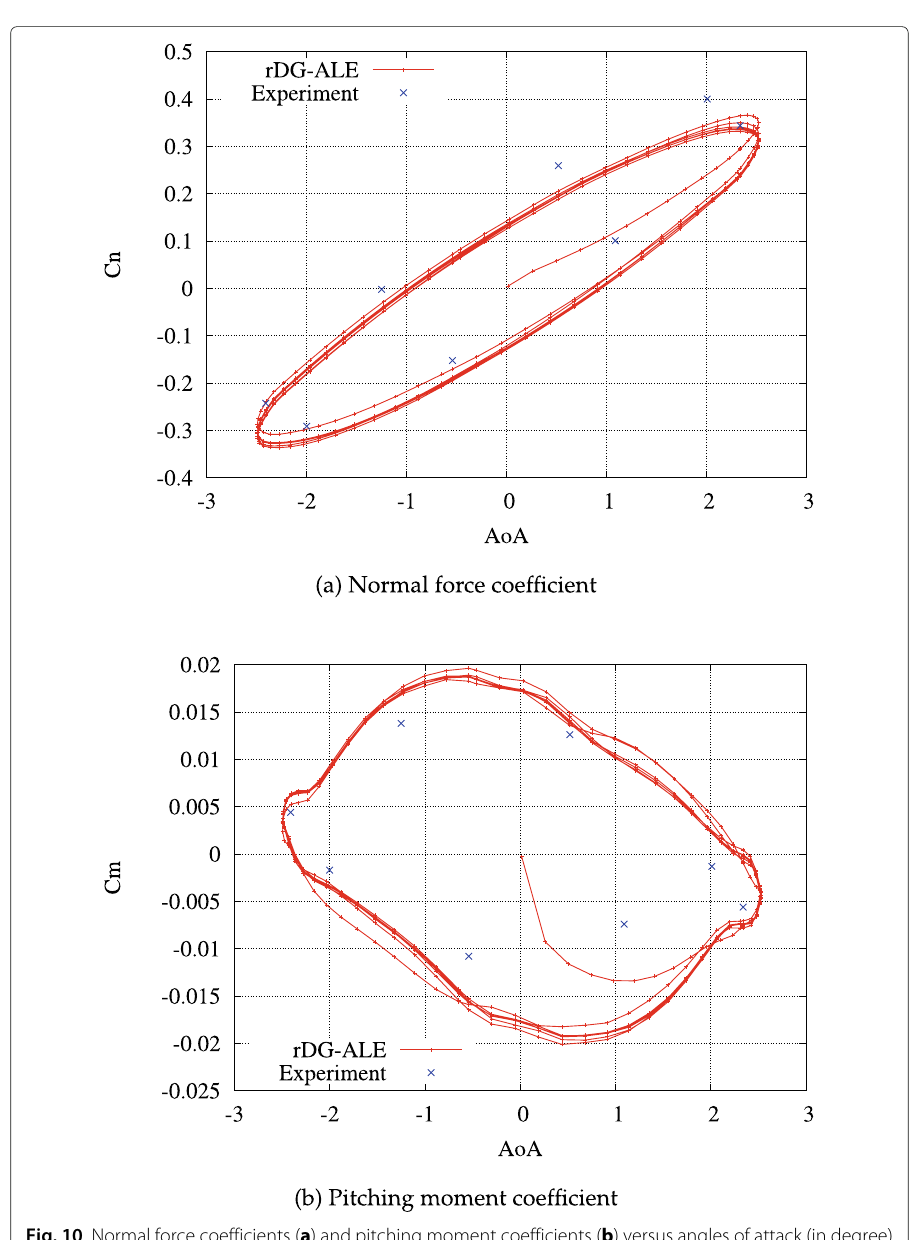
Fig. 10 Normal force coefficients ( a ) and pitching moment coefficients ( b ) versus angles of attack (in degree) of the pitching NACA0012